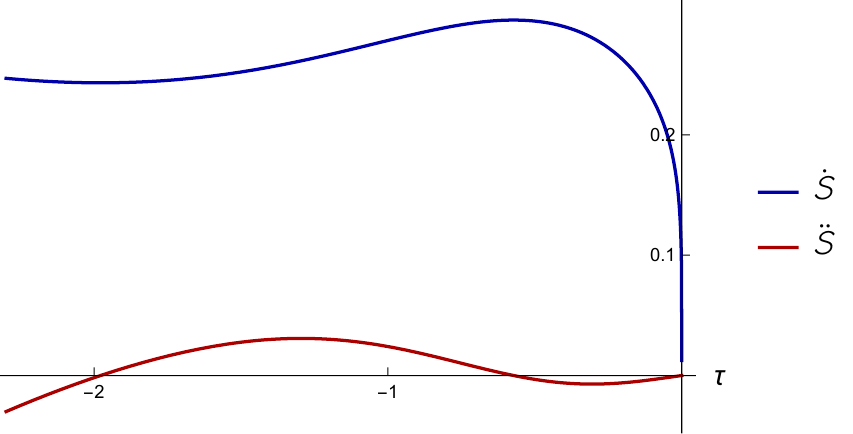
˙ ¨ S ( T ) , S ( T ) as a function of τ , for c A = 1 . In the τ → 0 limit, we have